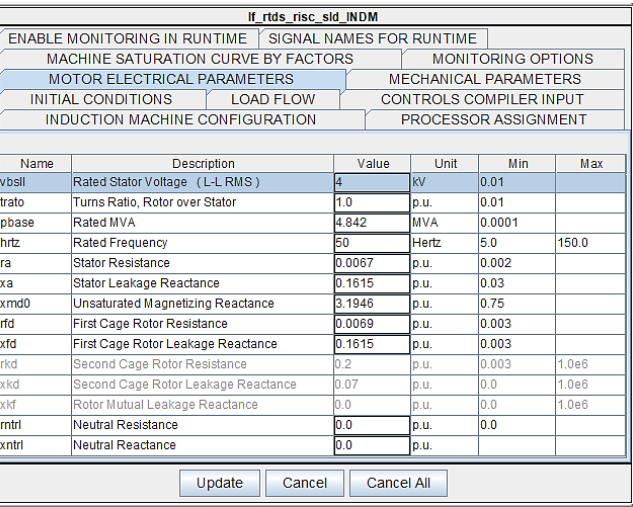
Figure 16. Squirrel - cage induction generator model electrical parameter settings. Figure 16. Squirrel-cage induction generator model electrical parameter